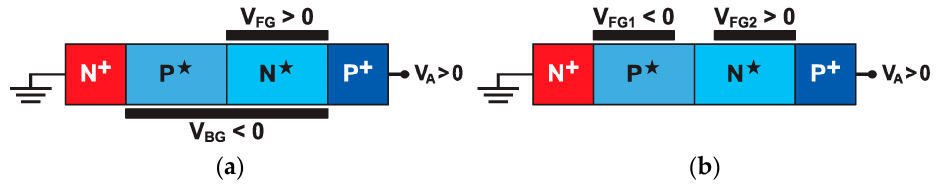
Figure 2. Configuration of band-modulation devices: ( a ) Z 2 –FET fabricated on FD-SOI and ( b ) field-effect diode implementable in nanowires and FinFETs.